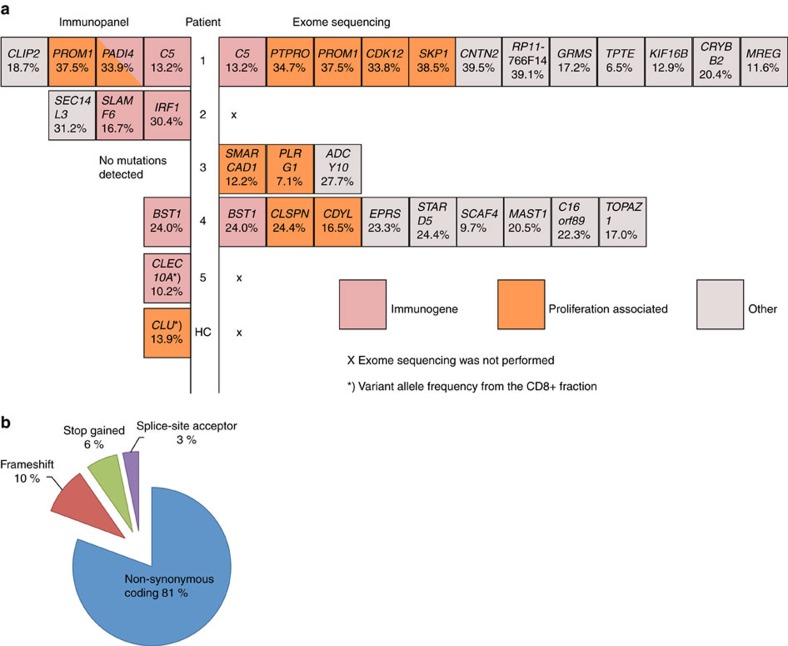
Somatic mutations are detected in 5 patients and in 1 healthy control.(a) Somatic mutations were discovered in newly diagnosed RA patients and in one healthy (HC) by using the immunogene panel (presented on the left side), and exome sequencing (presented on the right side of the figure). Proliferation-associated and immune-related genes are highlighted with different colours. Percentages below the gene names denote the VAFs in CD8+ cells (immunogene panel) or expanded Vβ cells (exome). (b) The frequency of non-synonymous coding, nonsense-, frameshift-, and splice-site mutations shown as percentage of all identified mutations. Silent mutations were excluded from the bioinformatics analysis.